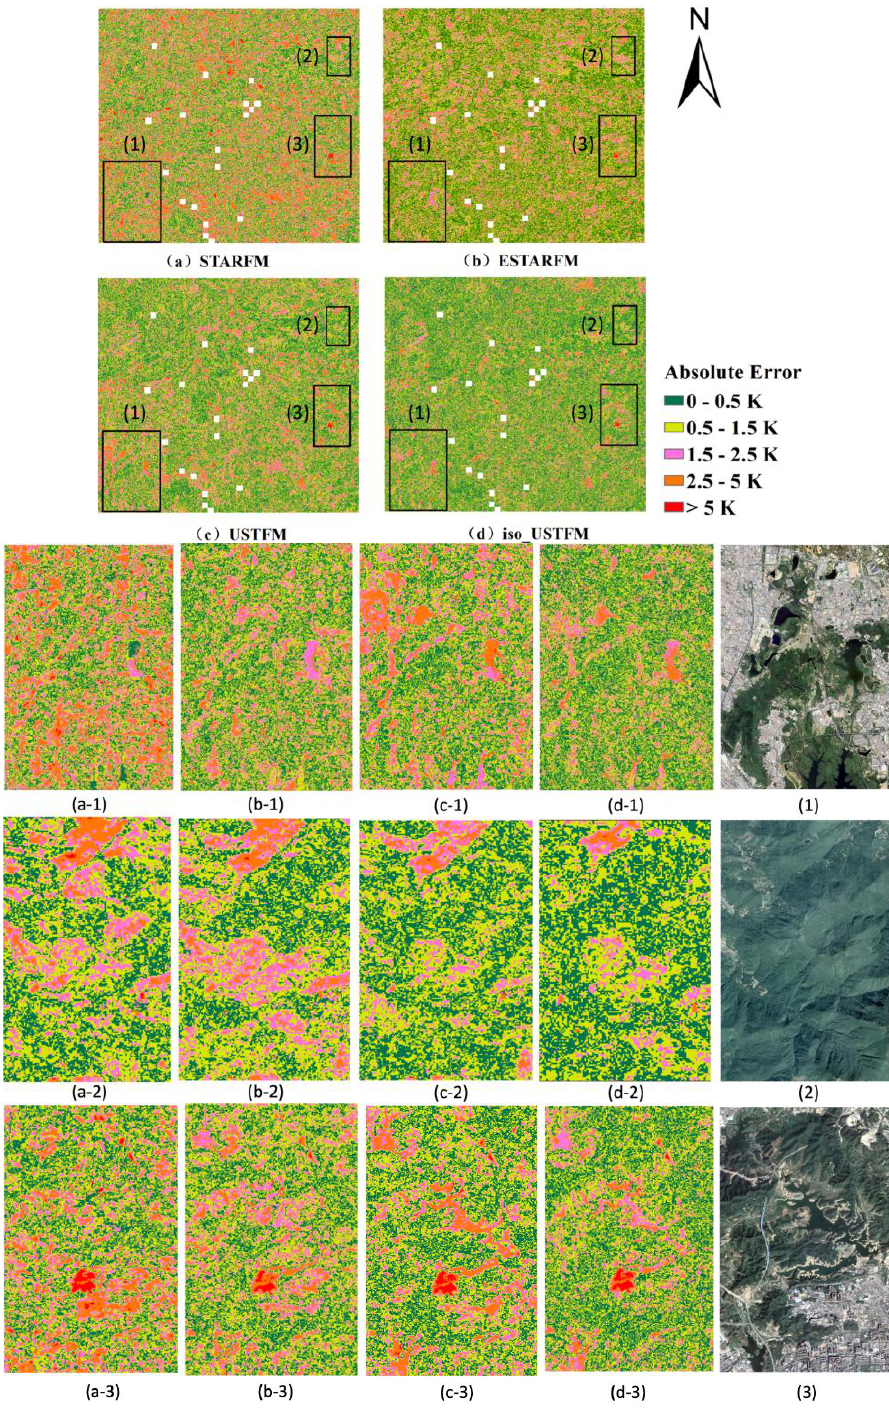
Figure 10. Comparison of the absolute error distribution of model fusion results on 20 November 2001. ( a ) STARFM, ( b ) ESTARFM, ( c ) USTFM, ( d ) iso_USTFM in three sub-regions: (1) city, (2) forest, (3) lakes The true-color composite Landsat 7 image from Google earth on 31 December 2001.